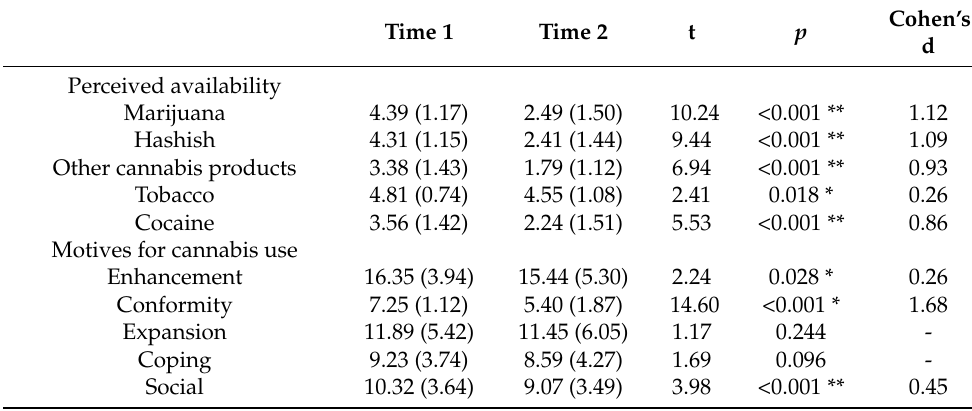
Table 2. Changes in perceived availability and motives for cannabis use.